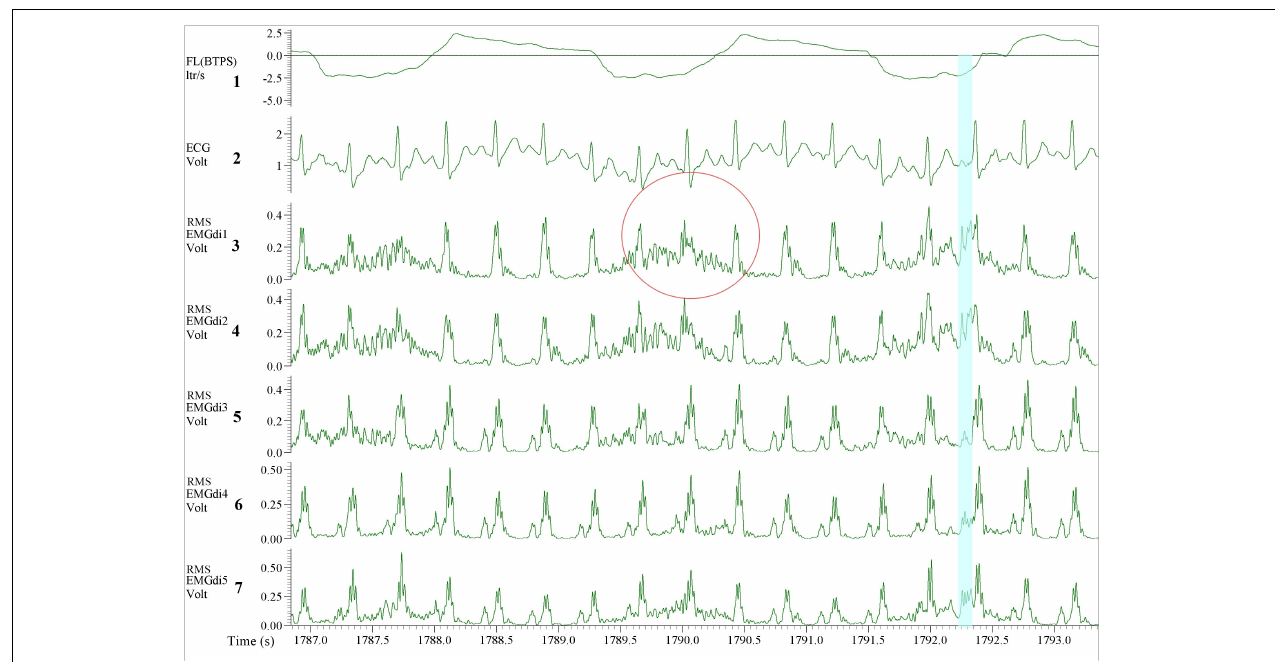
FIGURE 12 | Illustration of the EMGdi recordings during cycling exercise toward the end of the (symptom limited) cycling test when the inspiratory time (Ti) is shorter. Channel 1: respiratory flow (l/s; negative flow indicating the inspiratory cycle), Channel 2: ECG recording (volt), Channel 3–7: diaphragm EMG (RMS EMGdi) recordings. Several QRS complexes appear during the inspiratory cycle which is already a short period. The QRS complexes take up a large part during the inspiratory cycle resulting in less “clean” EMGdi to be selected. The red circle shows one inspiratory cycle when the QRS complex appears precisely at the peak of the amplitude of the EMGdi. The EMGdi buried under this QRS complex cannot be retrieved. Therefore, the assessor must choose the part outside of the QRS complex, which results in lower mean EMGdi value, thus underestimates the diaphragm activation. The blue highlight shows a small period of peak EMGdi. The mean EMGdi value of this period will be higher (average of high values in the short time) therefore the EMGdi being